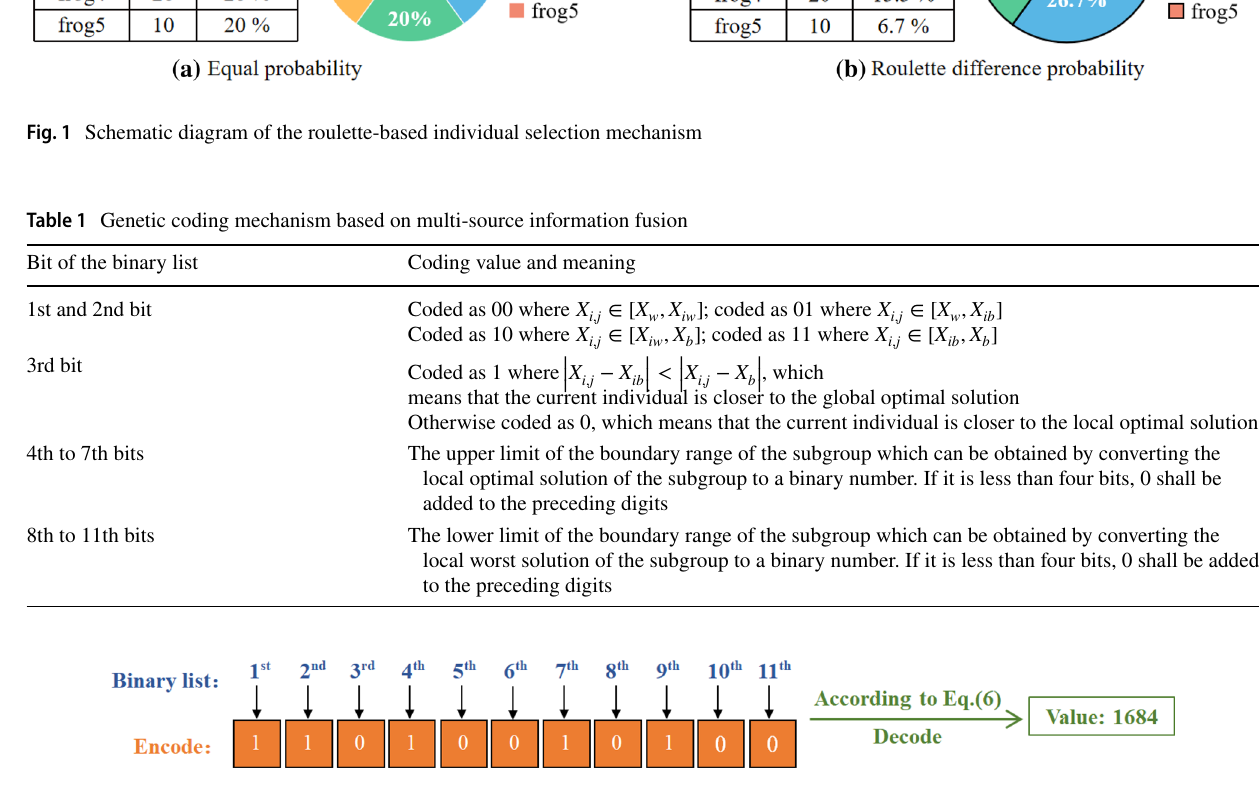
Fig. 2 An example of individual genetic